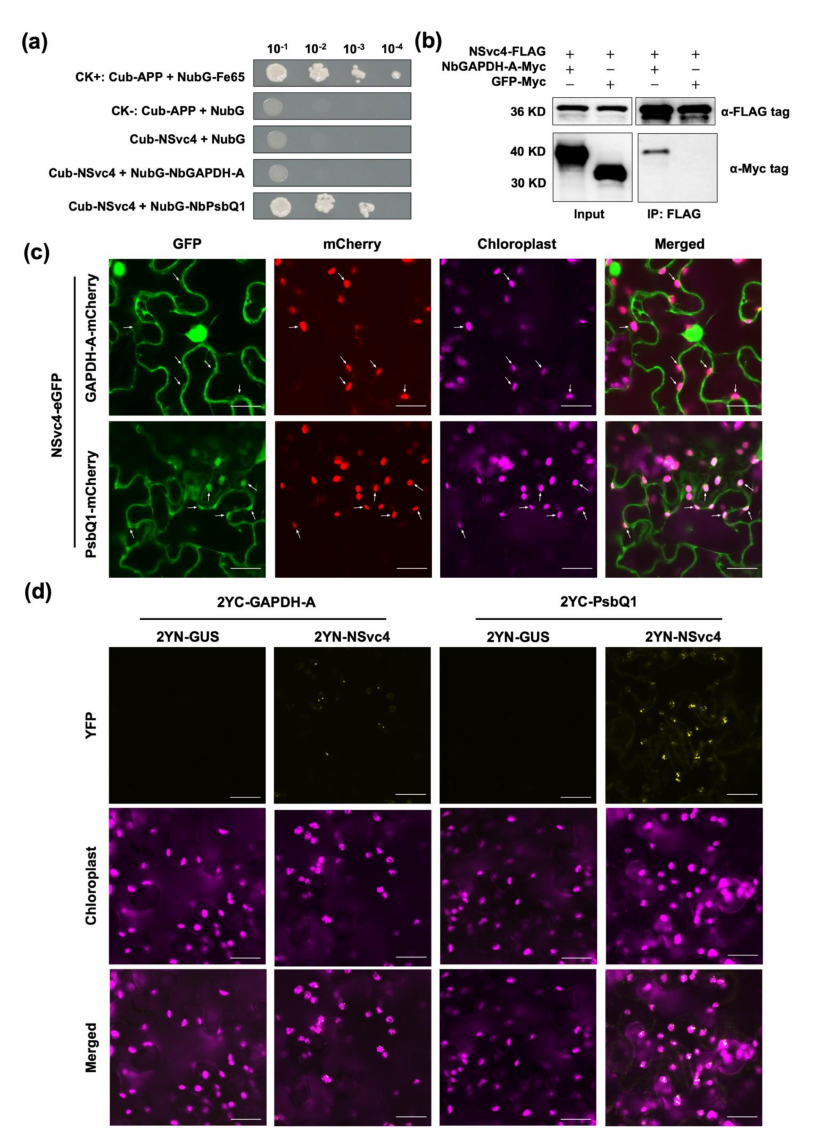
Figure 4. Identification of chloroplast-related host factors interacting with NSvc4. ( a ) Yeast split- ubiquitin assays. NSvc4 was fused to the C-terminal half (Cub), and NbGAPDH-A and NbPsbQ1 were, respectively, fused with the N-terminal half (NubG) of ubiquitin. Cub-APP co-transformed with NubG-Fe65 into yeast was used as a system positive control, Cub-APP co-transformed with NubG into yeast was used as a system negative control, and Cub-NSvc4 co-transformed with NubG into yeast was used as a negative control. A series of dilutions (10 − 1 , 10 − 2 , 10 − 3 , and 10 − 4 ) are shown from left to right. ( b ) Co-IP assay of NSvc4 with NbGAPDH-A. NSvc4-FLAG was co-expressed with NbGAPDH-A-Myc or GFP-Myc in N. benthamiana leaves. Forty-eight hours later, the leaf protein extracts were incubated with FLAG magnetic beads. Samples before (Input) and after immunoprecipitation (IP) were analyzed by Western blotting using anti-FLAG or anti-Myc antibodies. ( c ) Confocal images of N. benthamiana leaves infiltrated with agrobacteria carrying the combination of NSvc4-eGFP with GAPDH-A-mCherry and PsbQ1-mCherry, respectively. Arrows indicate the chloroplast localization. Bars, 20 µ m. ( d ) BiFC assays of NSvc4 with NbGAPDH-A and NbPsbQ1. Leaves were infiltrated with agrobacteria carrying the combinations of NSvc4 fused to the N-terminal part of YFP, with NbGAPDH-A and NbPsbQ1 fused to the C-terminal part of YFP, respectively, and GUS fused to the N-terminal part of YFP was used as a negative control. Samples were observed by laser confocal microscopy at 48 hpi. Bars, 20 µ